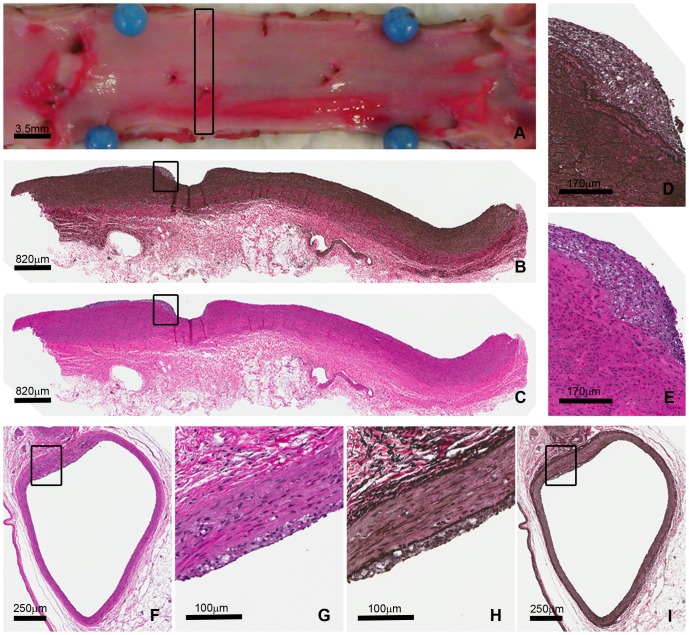
Abdominal aortic and coronary atherosclerosis in a 26-week-old LDLR−/− pig fed a standard diet.Measurements of percent surface area with raised lesion in the abdominal aorta were taken from en face photographs of the abdominal aorta and confirmed by Sudan IV staining (A). Aortic sections (rectangle) were stained with VVG and H&E (B,C), higher magnifications of atherosclerotic lesion (squares) are seen in D and E. A representative section (with corresponding higher magnification) from the circumflex artery showing atherosclerotic plaque that appears to have foam cells. (F,G–H&E H,I – VVG).